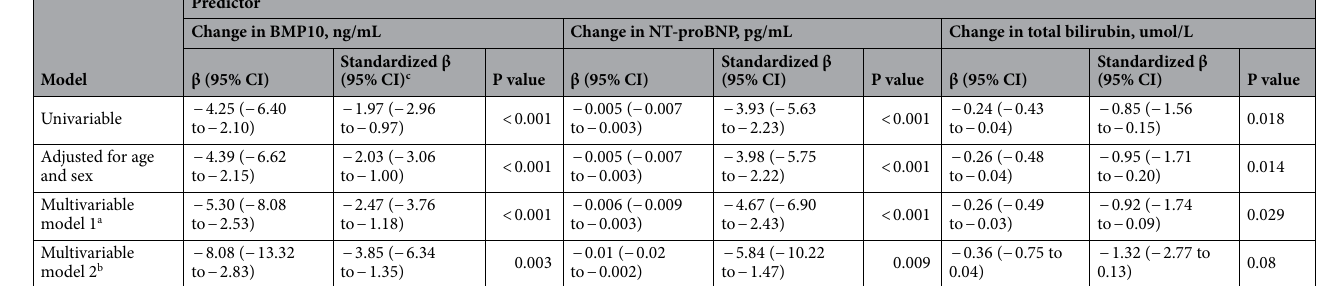
Table 5. Associations of change in biomarker levels with rhythm status after cardioversion. Estimates were obtained from logistic regression models where rhythm status at follow-up was the dependent variable and change of biomarker was the independent variable. All models were adjusted for biomarker levels at baseline. a Adjusted for age (years), sex, BMI (kg/m 2 ), smoking status (active, past, never), hypertension (yes vs